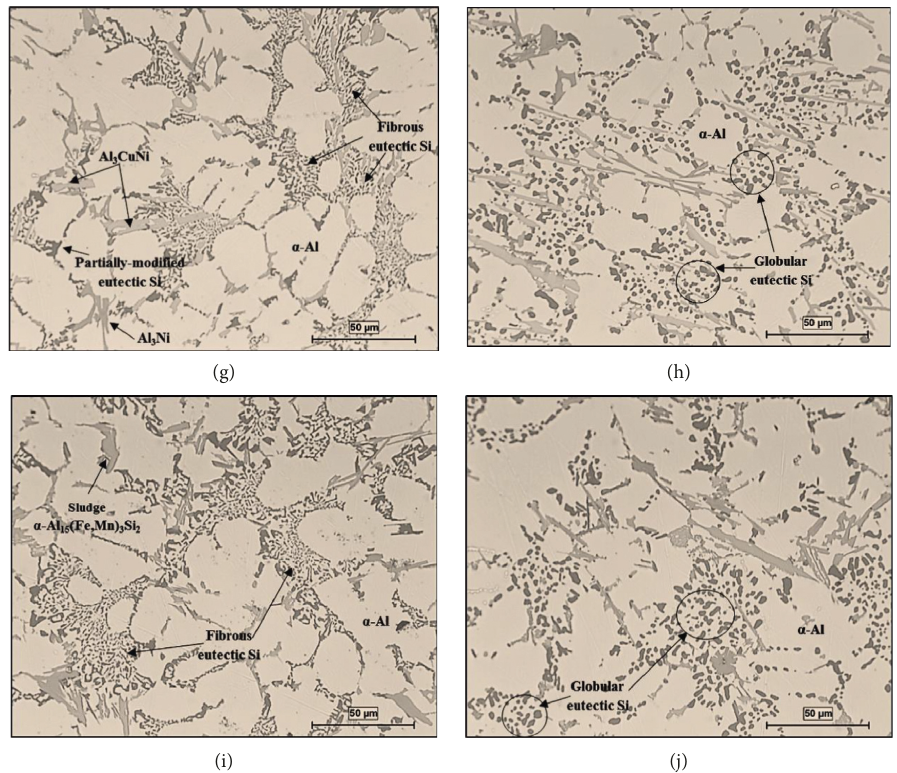
Figure 2: Optical micrographs at 500X showing the morphology of the eutectic silicon in the alloys studied: (left) as-cast conditions and (right) solution heat-treated conditions: (a) as-cast alloy M1S, (b) SHTalloy M1S, (c) as-cast alloy M2S, (d) SHTalloy M2S, (e) as-cast alloy